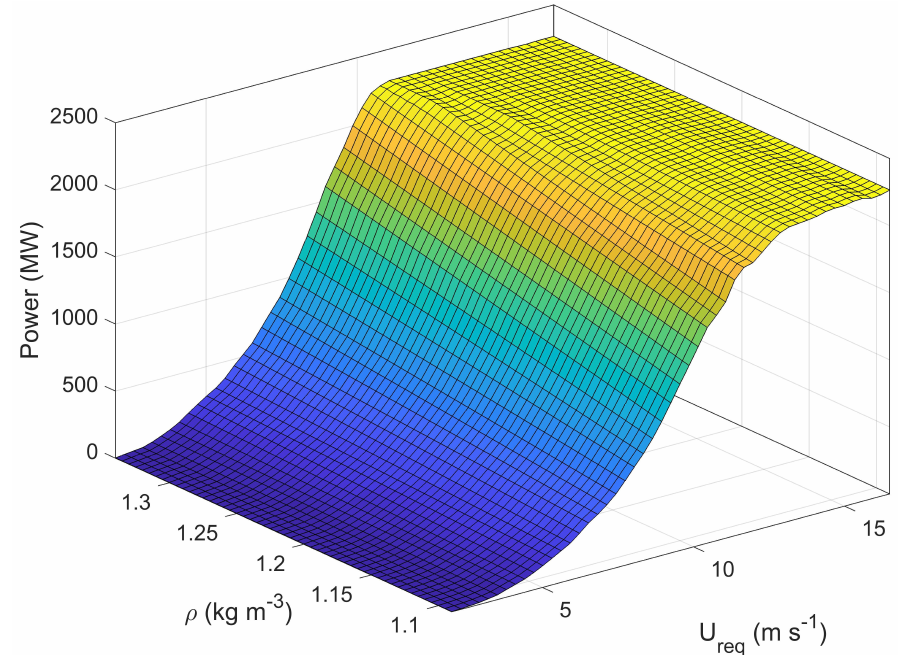
Figure 14. Power surface generated from interpolated binned